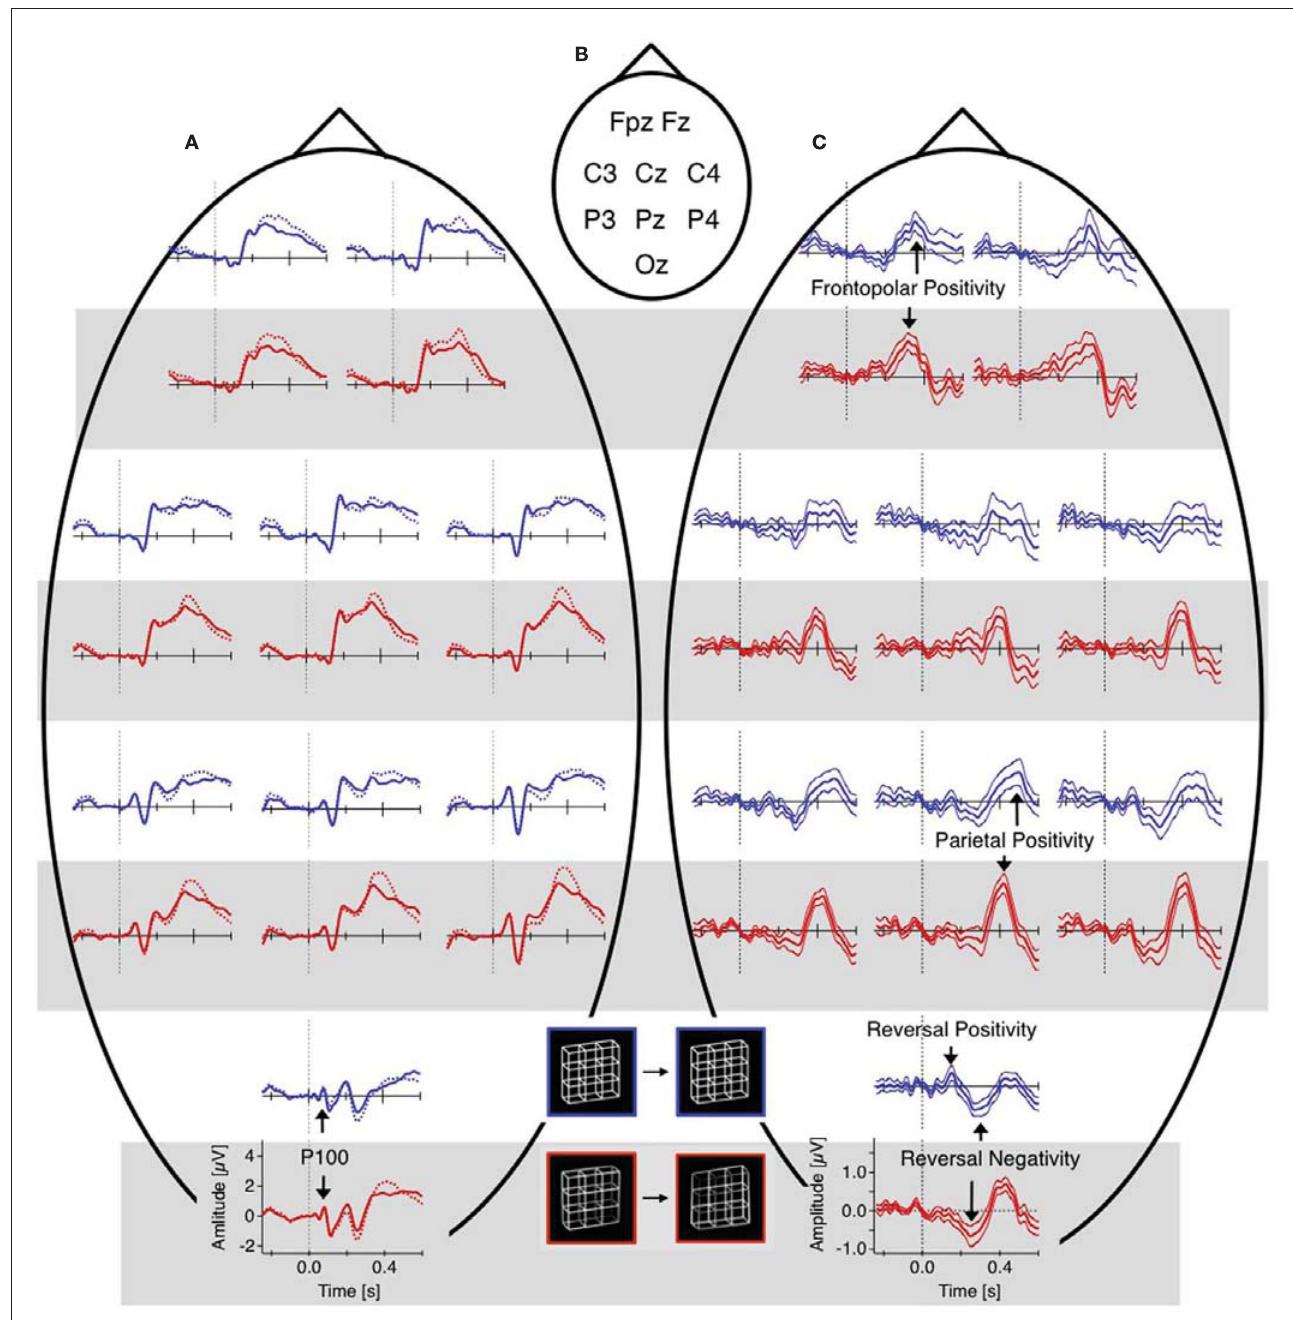
traces) and across experiments (ambiguous and unambiguous stimuli). This is especially true for the early visual ERP components at the occipital electrode position). (C) Difference traces (reversal minus stability). Differences ERPs (dERPs) are very similar between ambiguous and unambiguous stimuli with two exceptions: (1) All dERPs found with unambiguous stimuli occur earlier and (2) the early occipital Reversal Positivity (RP) is restricted to endogenous perceptual reversals of ambiguous Necker lattices. Data from Kornmeier and Bach